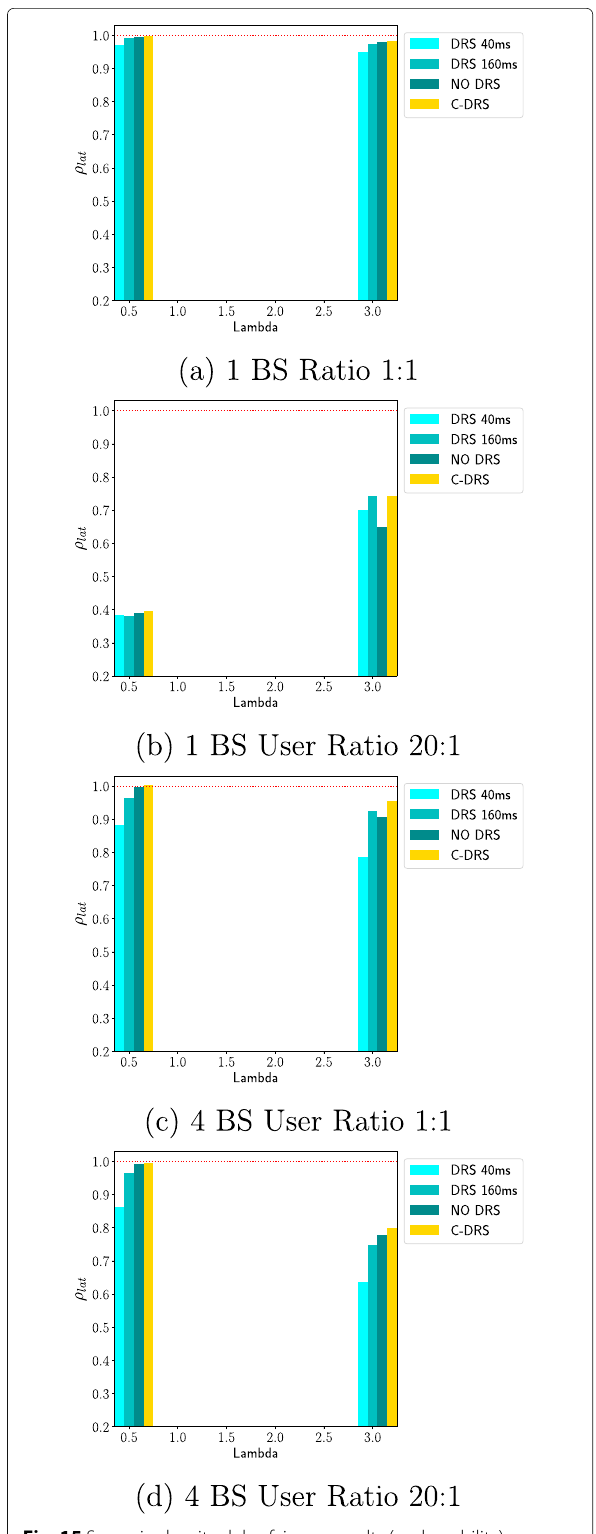
Fig. 15 Scenario density delay fairness results (ped.